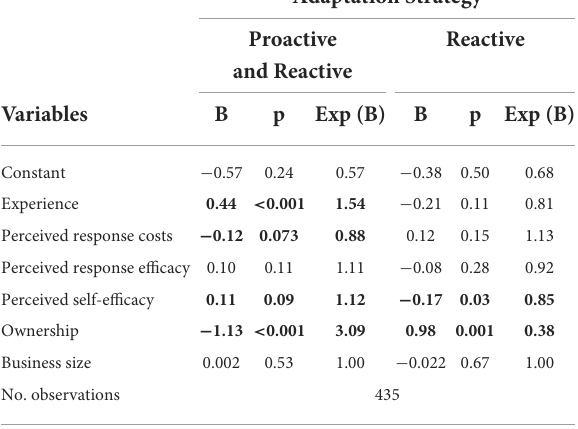
TABLE 10 Influence of various factors on adaptation behavior (data: businesses in Germany damaged by the 2013 flood).